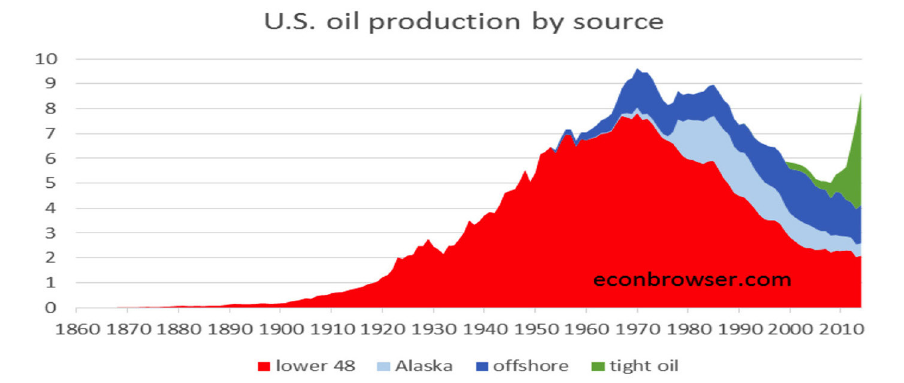
Fig. 12. – US oil production up to a few years ago. (Courtesy of Prof. Hamilton.)